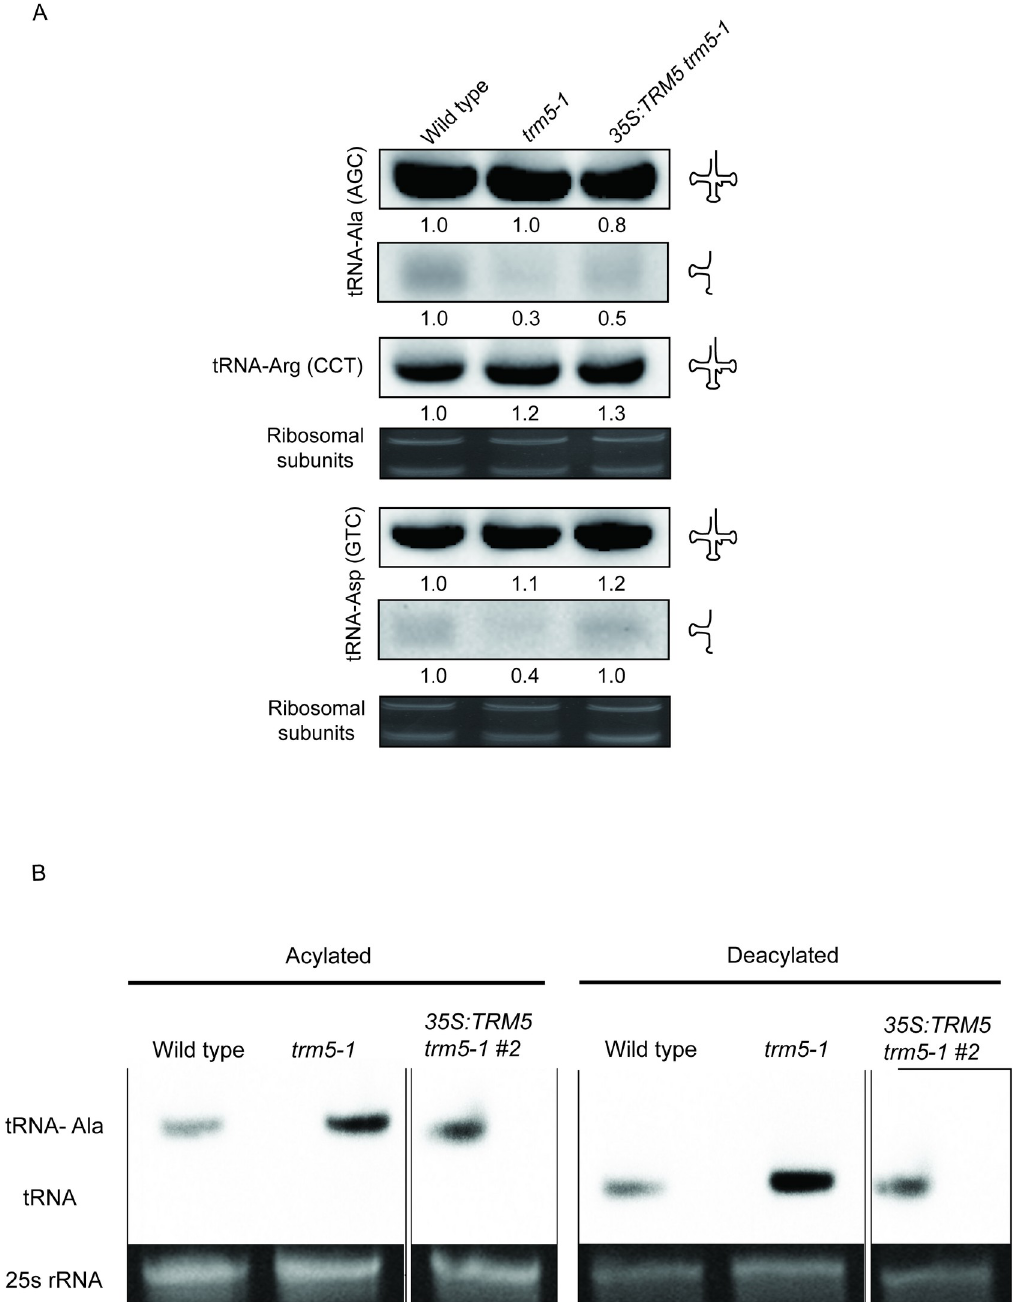
Fig 8. Loss of function of AtTRM5 affects tRNA halve abundance. ( A ) Northern blot analysis of RNA from wild type, trm5-1 and 35S : TRM5 trm5-1 . tRNA-Ala (AGC) was inspected for changes in m 1 G37 and tRNA-Asp (GTC) and m 1 I37. tRNA-Arg (CCT) and rRNA were used as loading controls. The blots were probed with either tRNA-Arg (CCT), tRNA-Asp (GTC), or tRNA-Ala (AGC). ( B ) Accumulation and aminoacylation of tRNA-Ala (AGC) in wild-type plants, trm5-1 mutant plants and 35S: TRM5 trm5-1 . The aminoacylated tRNA migrates slower than its corresponding deacylated species. To visualize the difference in electrophoretic mobility, aliquots of the same samples were deacylated in vitro . 10 μ g of RNA was separated by electrophoresis, blotted and hybridized to a tRNA-Ala (AGC)-specific probe. The 25S rRNA band of the ethidium bromide- stained gel prior to blotting is shown as a loading control.